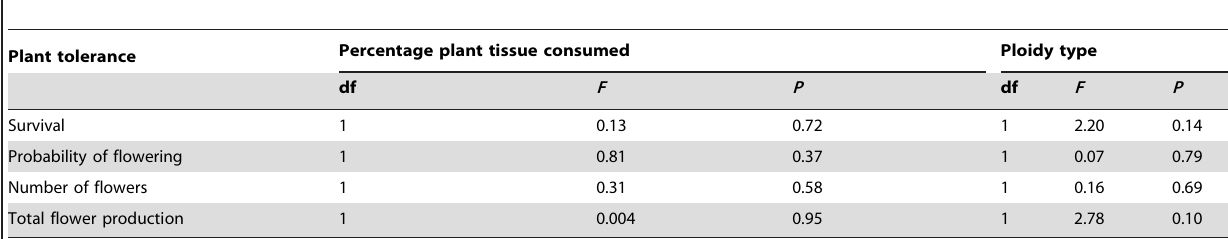
Table 2. Relationship between the proportion percentages of plant tissue consumed by the developing larvae and four estimates of plant tolerance in two ploidy types of Cardamine pratensis .